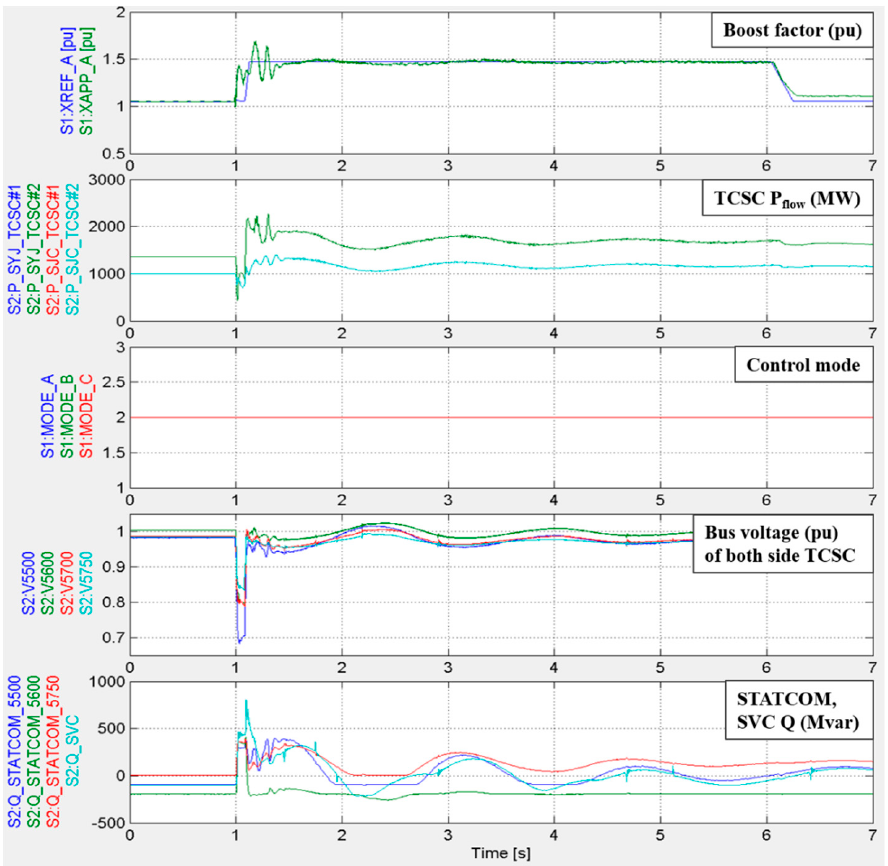
Figure 7. TCSC and other FACTS output.